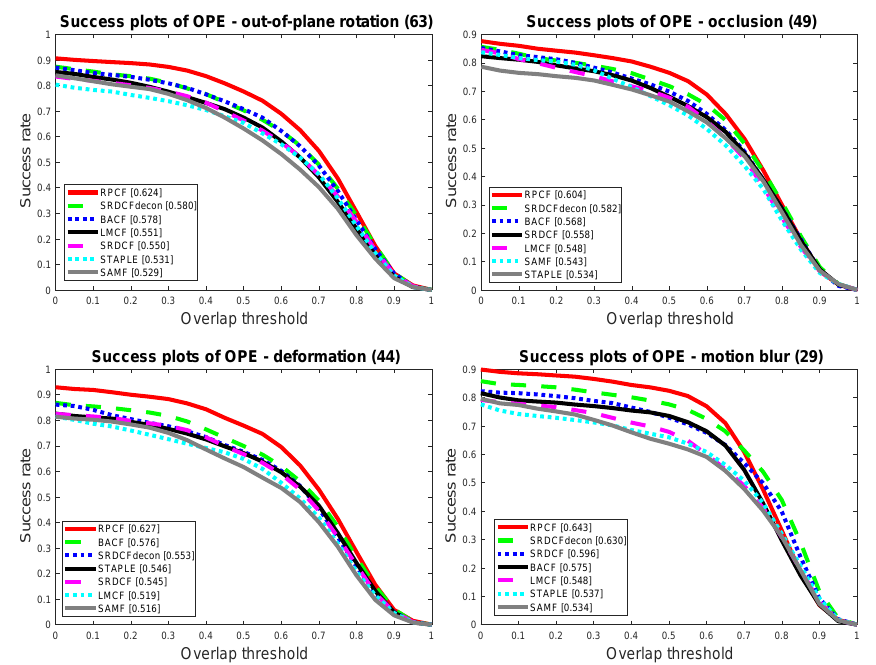
Figure 9. Different tracking conditions analysis of